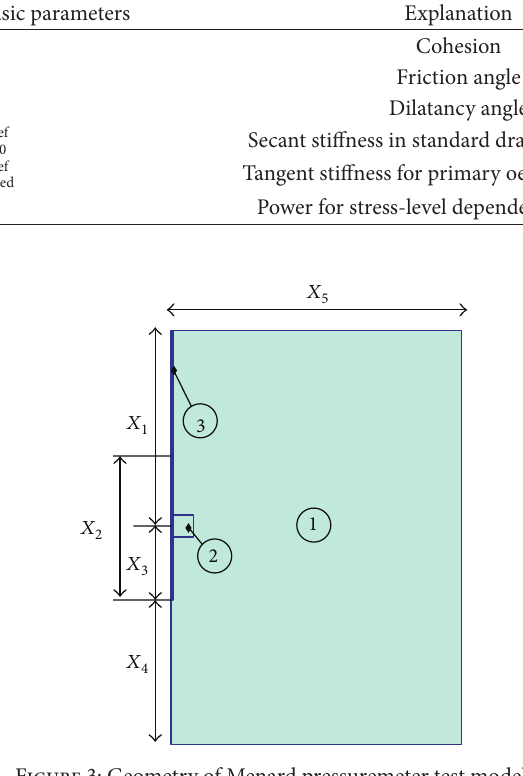
Figure 3: Geometry of Menard pressuremeter test model.